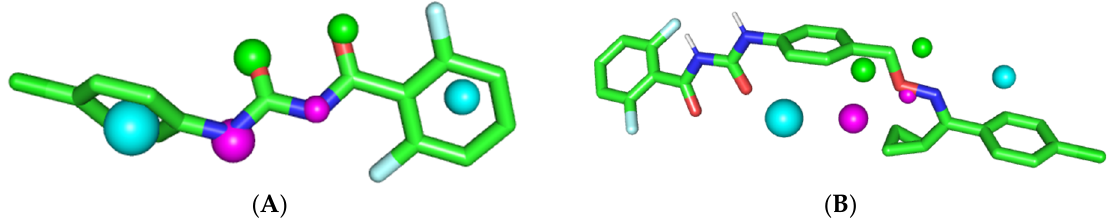
Figure 2. ( A )—potent inhibitor (0.001 mg·L −1 ; QFIT = 84.94); ( B )—flucycloxuron (0.05 mg·L −1 ; QFIT = 58.66), superposed to model pharmacophore 06. Spheres represent H-bond donors (green), H-bond acceptors (magenta) and hydrophobic groups (cyan). The size of spheres varies according to the tolerance radius calculated using GALAHAD TM . All the distances are measured in angstroms.